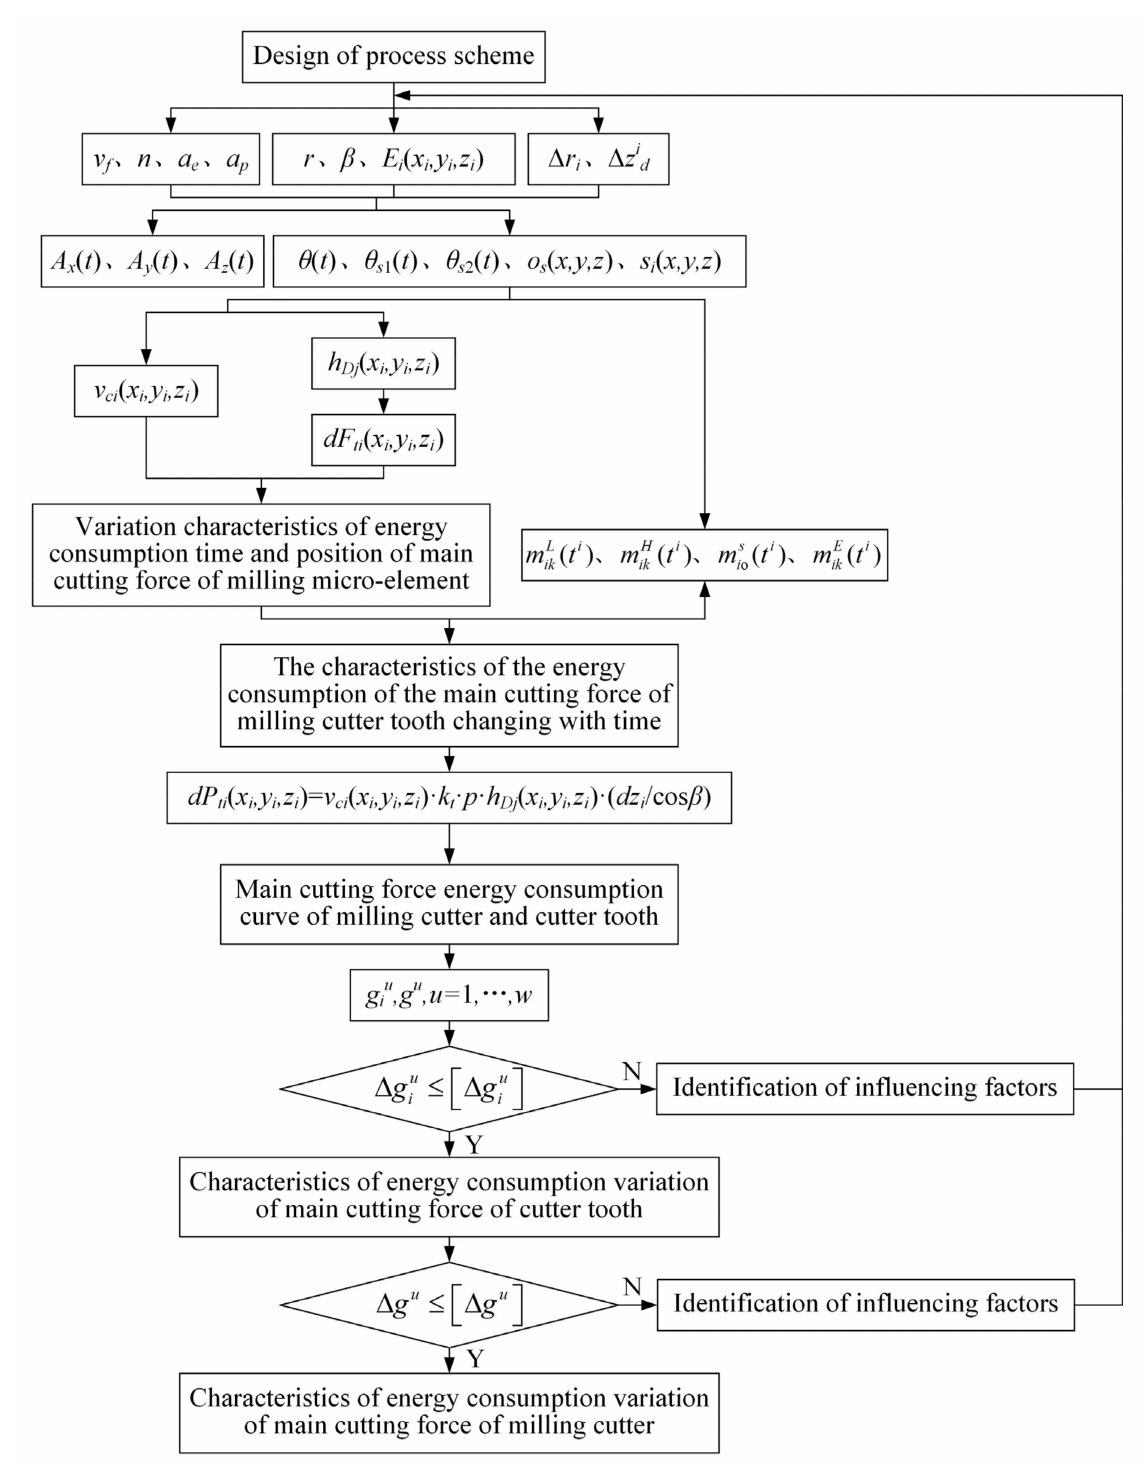
Figure 10. Identification method for the dynamics of the main cutting force energy consumption of the milling cutter and its cutter